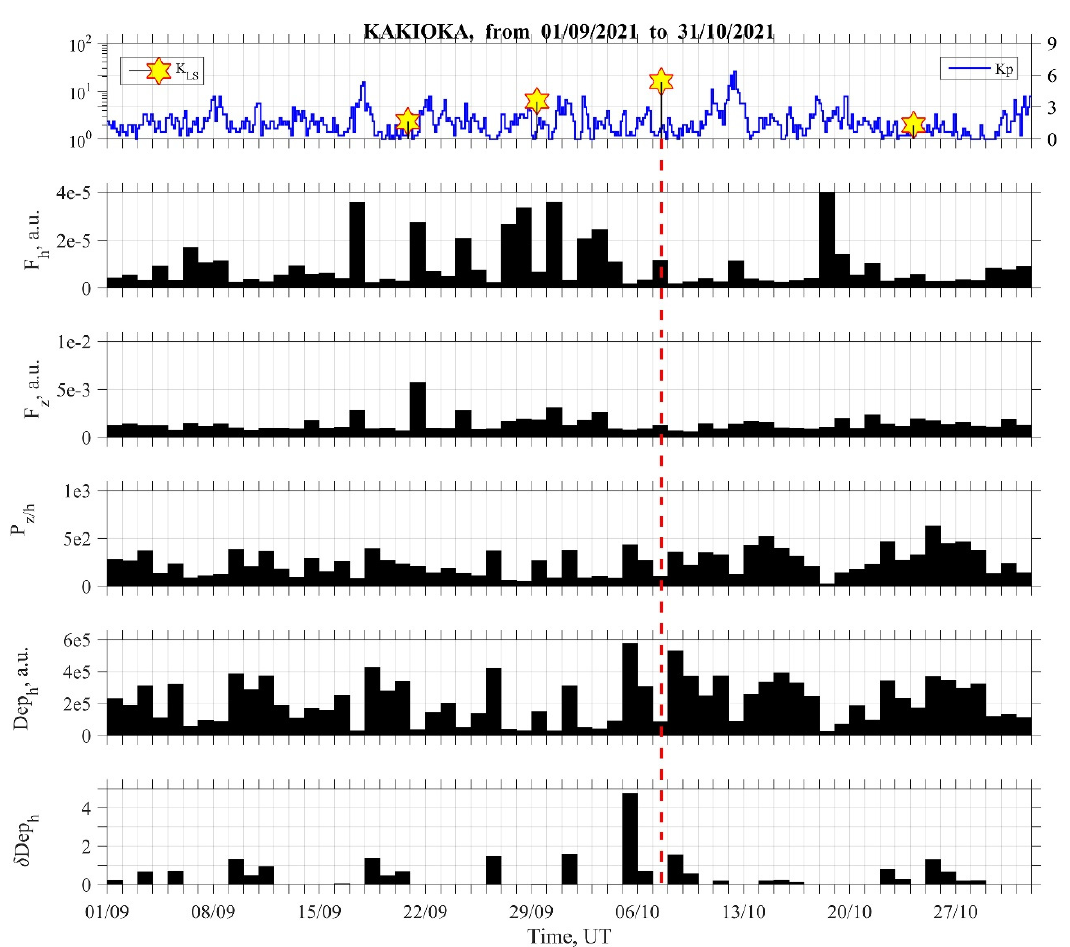
Figure 16. Bottom two panels refer to the characteristics of ULF depression (depression D eph and relative depression δ D eph ). Top panel refers to the magnetic ( K p ) and local seismic activity ( K LS ). A vertical dotted red line is the occurrence time of our EQ. For the sake of comparison, we have reproduced the results of the lithospheric ULF radiation (Figure 2); the second and third panels refer to F h and F z , and the fourth panel to polarization P z / h .